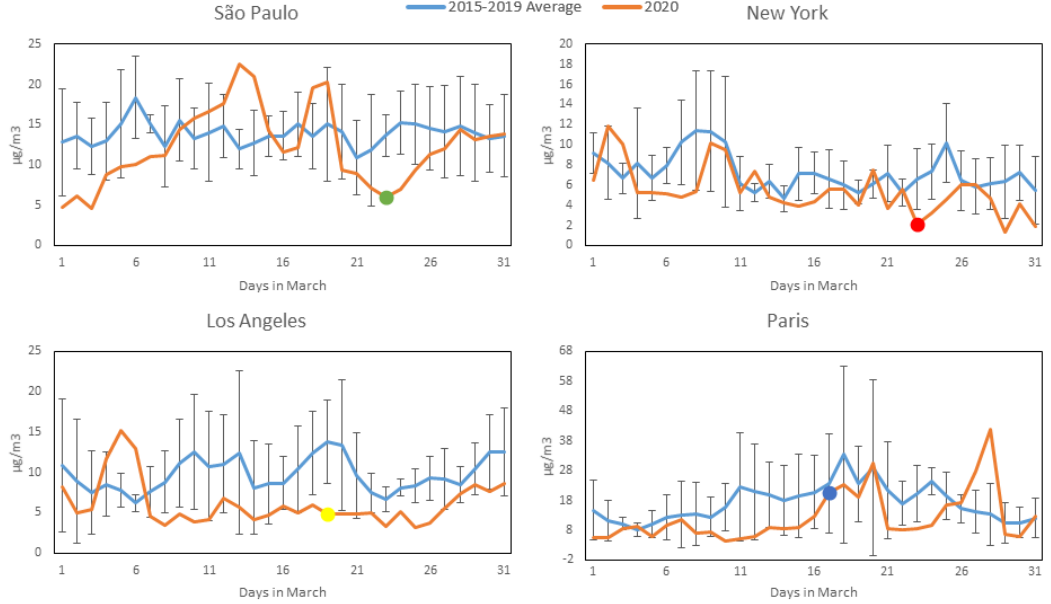
Figure 5. PM 2.5 concentration profiles during March 2020 (Orange) compared to average and standard deviation of March concentrations over the previous 5 years (Blue) for the four studied cities (most significant COVID-19 intervention date indicated with colored dot). All available station data used for each city (see Section 2.2).